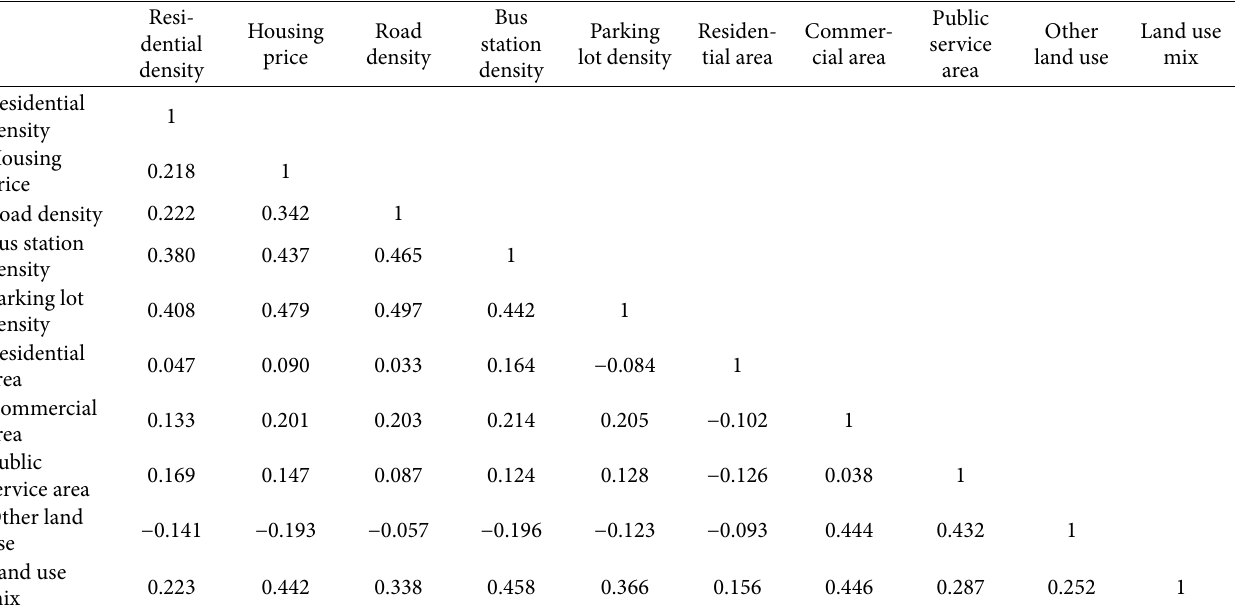
Table 2: Correlation matrix.